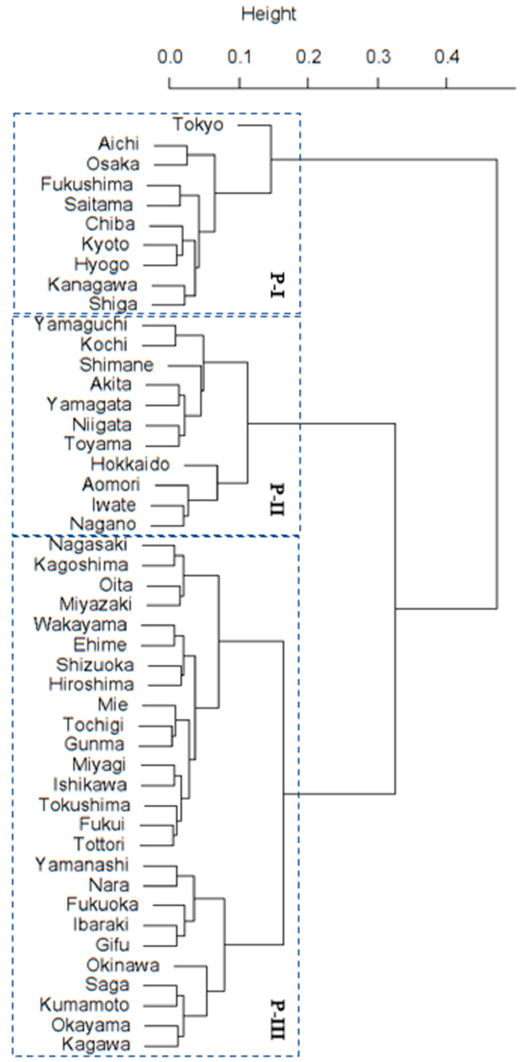
Figure 2. A dendrogram for the vehicle price categories. See Figure A1a for the mapping of the cluster analysis results.